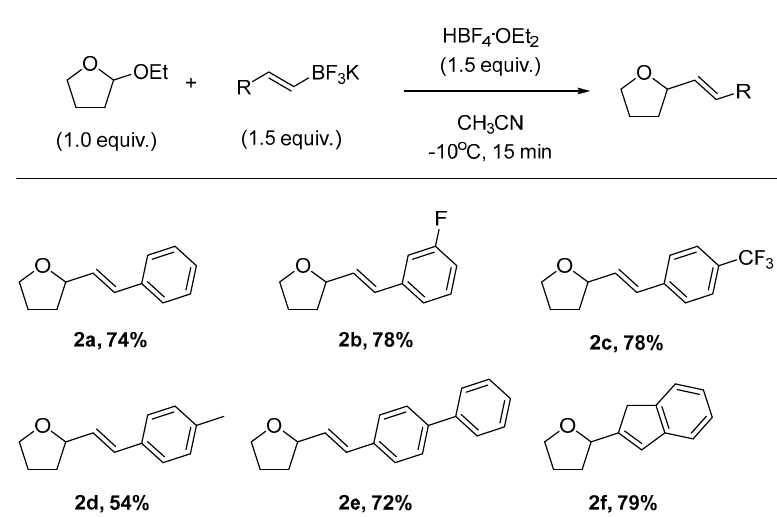
Figure 2. Reactions of potassium trans ‐ styryltrifluoroborate salts with 2 ‐ ethoxytetrahydrofuran.